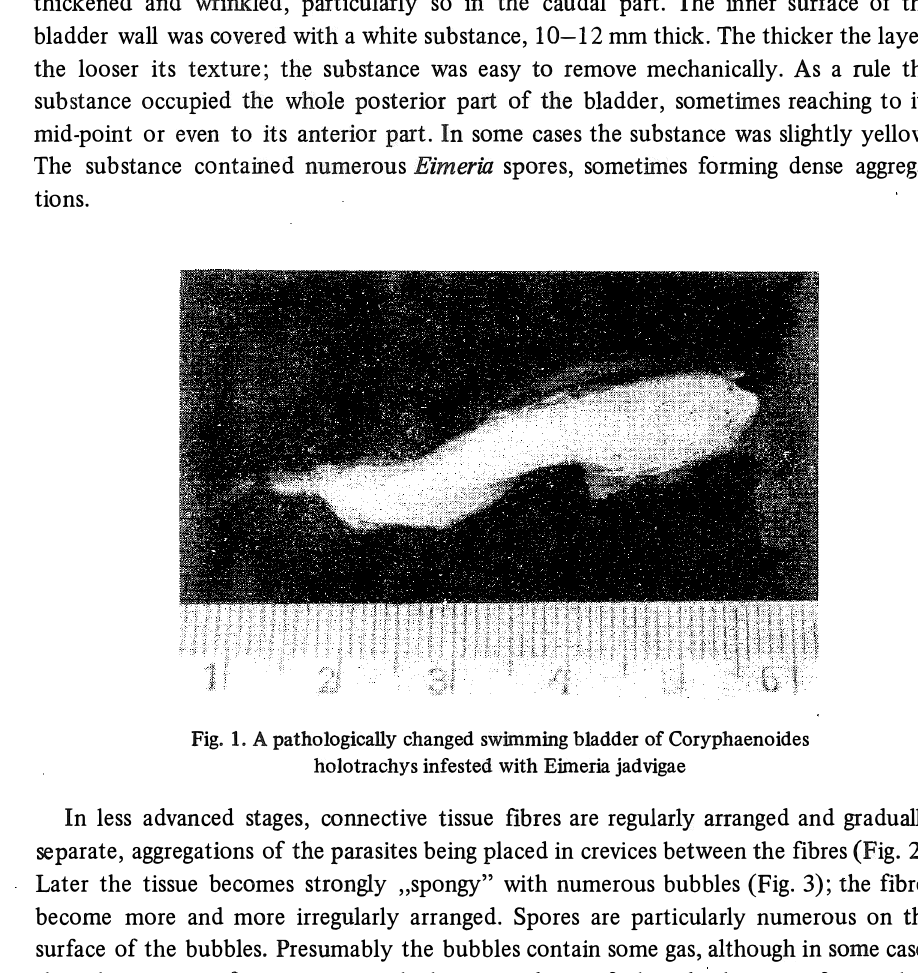
Fig. 1. A pathologically changed swimming bladder of